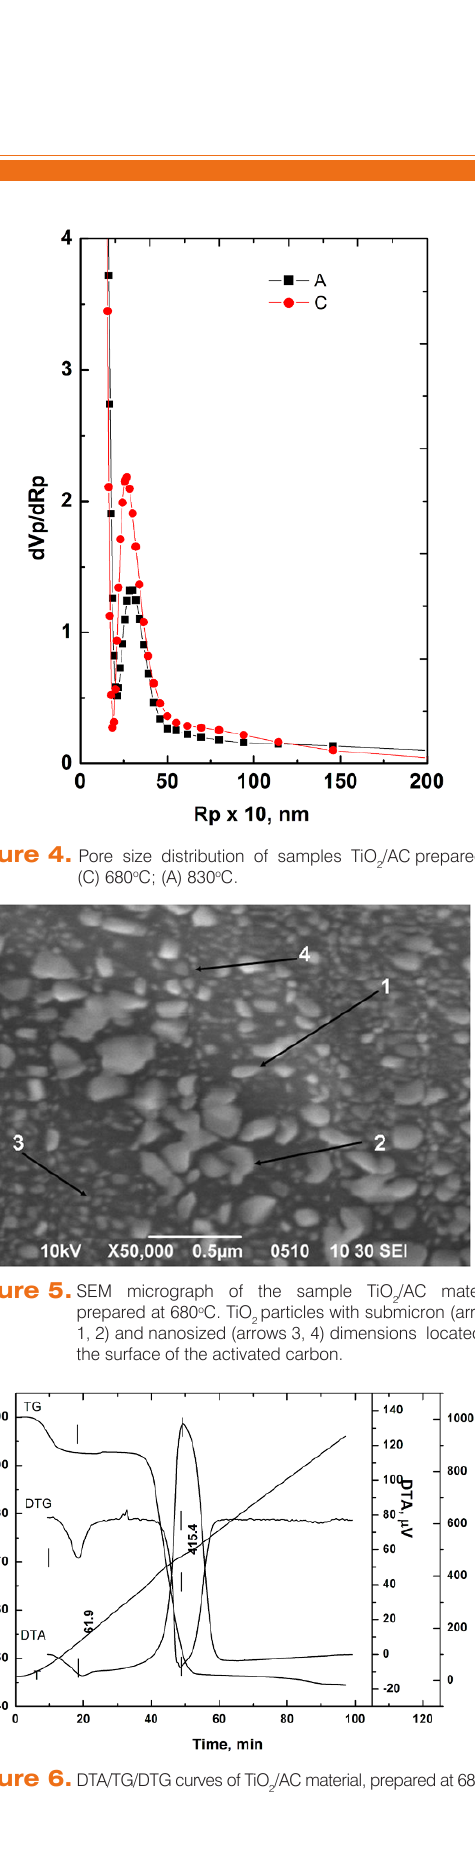
/AC material, prepared at 680 o C. 2